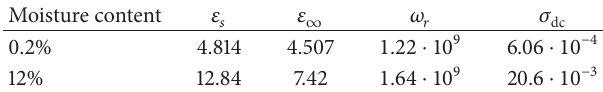
Table 1: Parameters for concrete Debye model as per [10].